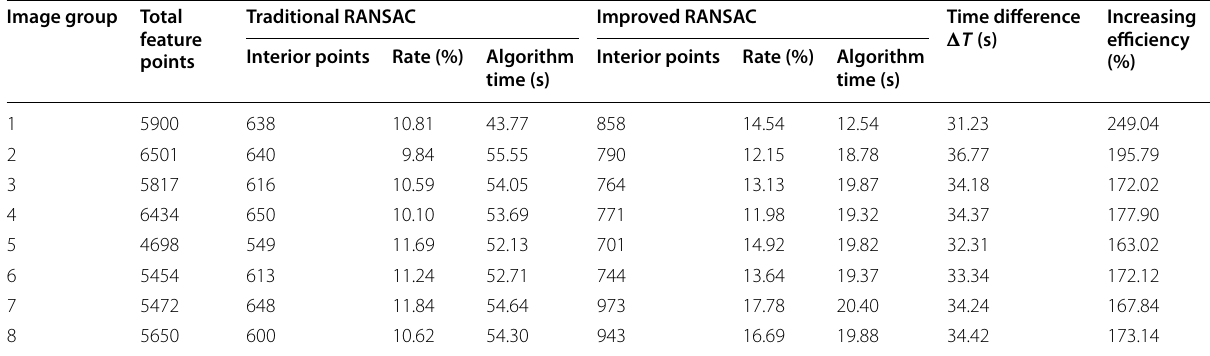
Table 3 Comparison between the improved RANSAC algorithm and the traditional RANSAC algorithm Image group Total feature